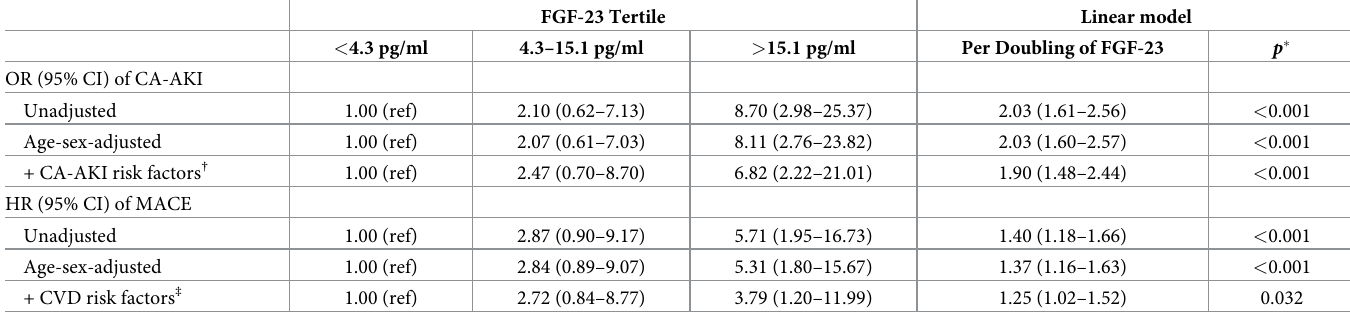
Table 3. Risk of incident CA-AKI and incident MACE by baseline levels of